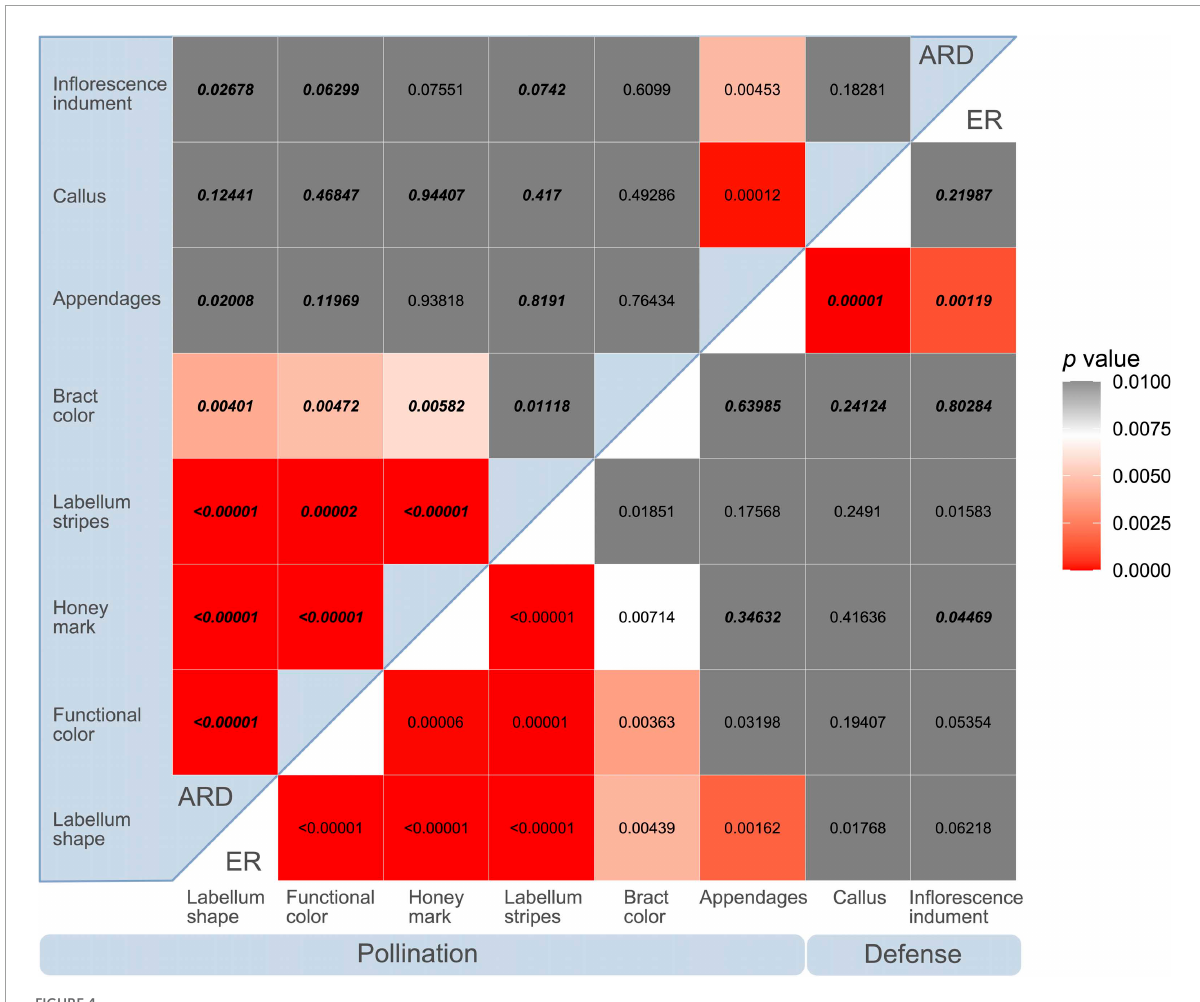
FIGURE4 Heatmap showing the p -values for the independent evolution model based on a Chi-squared test to compare with Pagel’s model of correlated evolution of traits associated with pollination or with defenses against herbivory. Results are shown for equal transition rates (ER) and all rates different (ARD) models for each possible pair of traits. The p -value of the model with lower AIC value for each pair is shown in bold, bigger and italicized font. The color scale was adjusted to reflect the correction for multiple comparisons with white cells for the values close to the significance threshold (0.007143); red cells indicate significant p -values and correlated evolution and gray cells non-significant values and independent evolution of the pair of